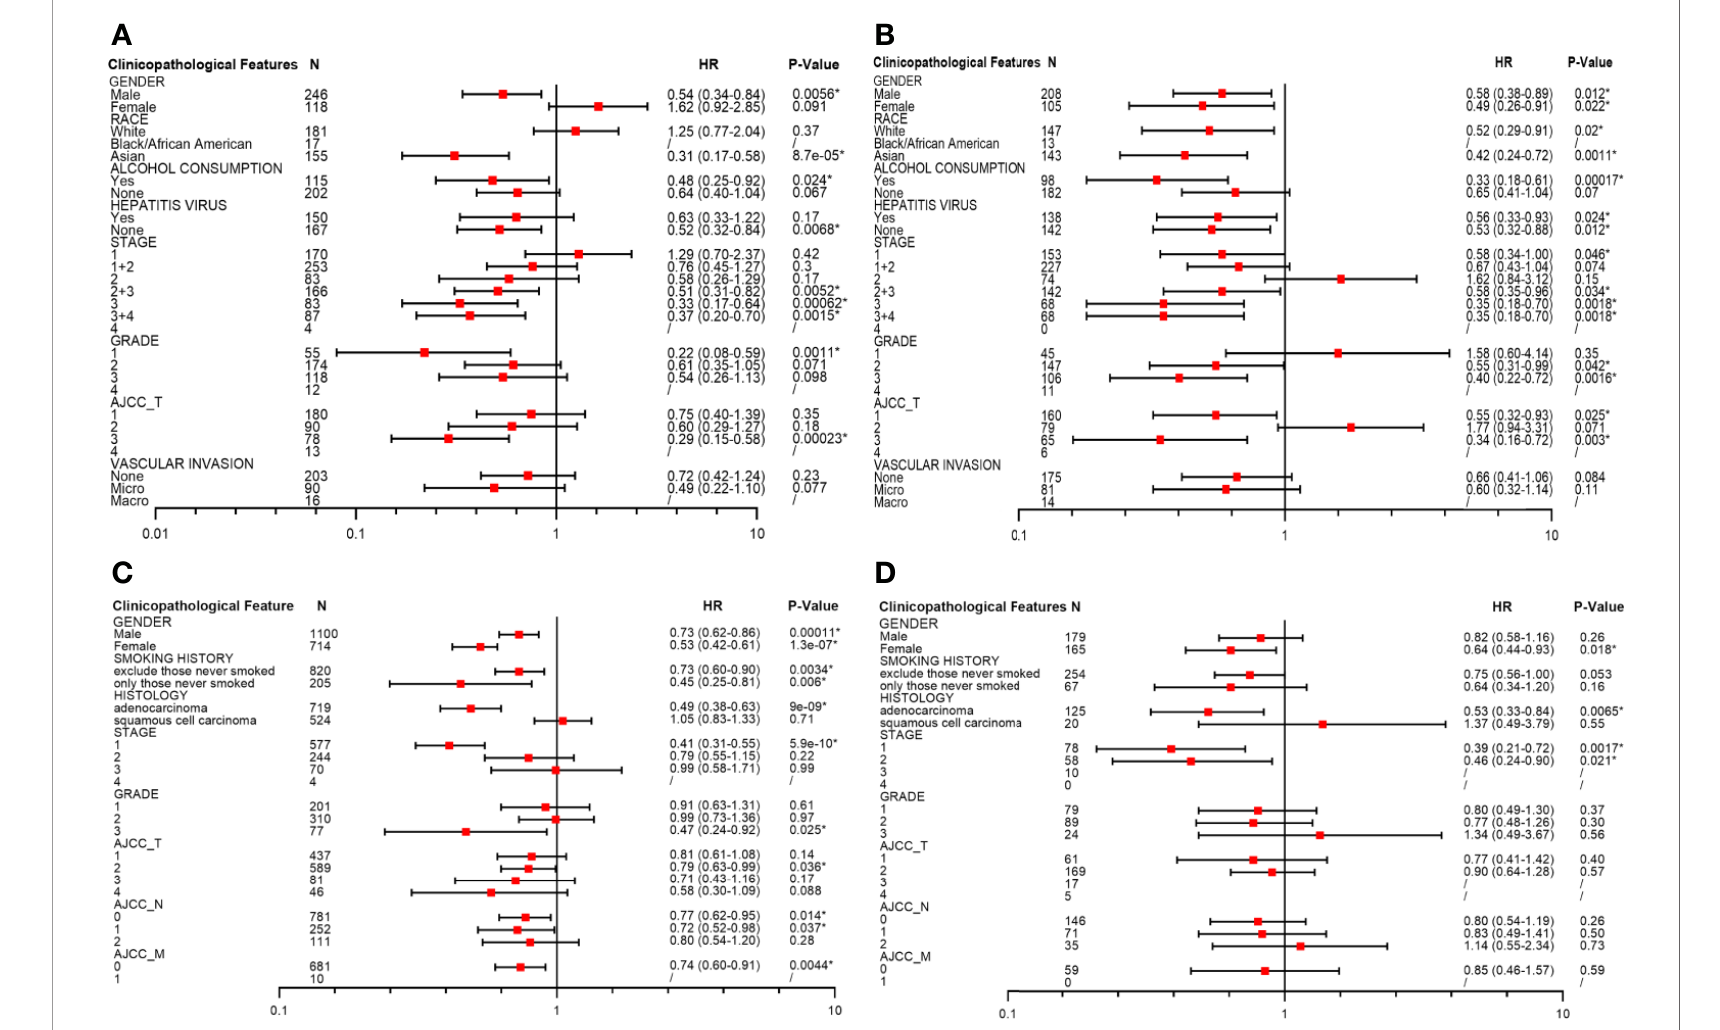
FIGURE 4 | Survival analyses of PINK1 with different clinicopathologic features in liver hepatocellular carcinoma and lung cancer. (A) Correlation of PINK1 mRNA expression with OS in liver hepatocellular carcinoma. (B) Correlation of PINK1 mRNA with RFS in liver hepatocellular carcinoma. (C) Correlation of PINK1 mRNA expression with OS in lung cancer. (D) Correlation of PINK1 mRNA with PPS in lung cancer. *P < 0.05. HR, hazard ratio; OS, overall survival; RFS, relapse free survival; PPS, post progression